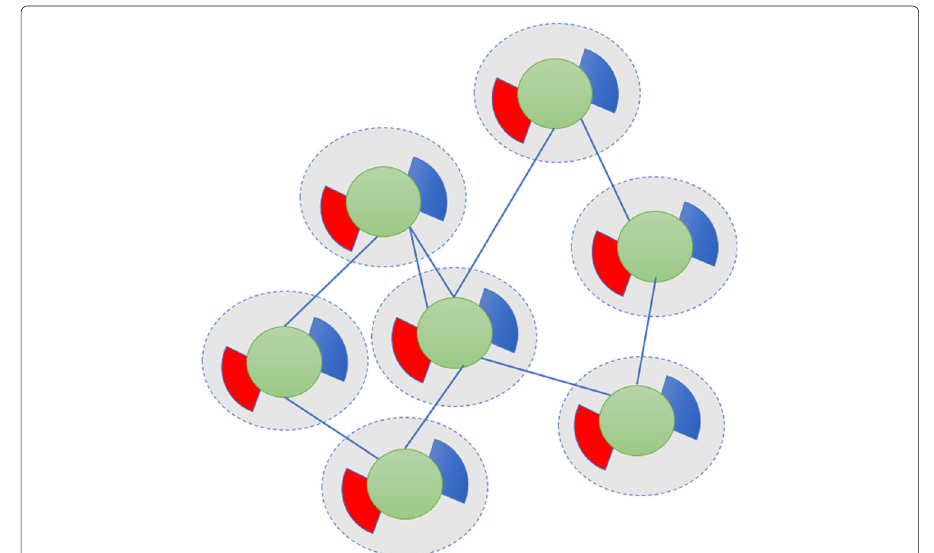
Fig. 6 Schematic diagram of the Google-web network with local bow-tie structure as demonstrated in Figure 5. Each community of the network depicted by dotted circle, is characterized by the bow-tie structure composed of IN (red), SCC (green) and OUT (blue) parts